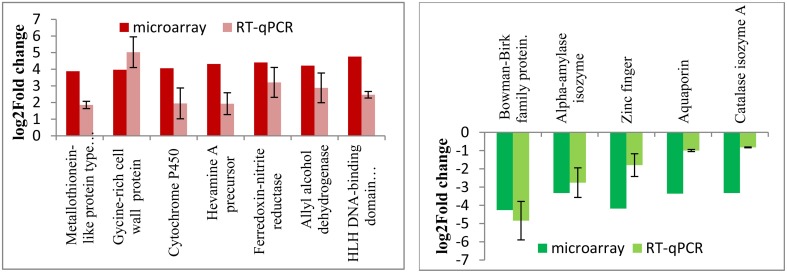
qRT-PCR validation of RGA1-regulated genes identified as common to various abiotic stresses. Out of the 1498 RGA1-regulated genes identified as common to multiple abiotic stresses on the microarray, 12 of the most up/down-regulated genes were validated by qRT-PCR. Their fold change data are shown based on averages of two biological replicates and two technical replicates of total RNA, along with microarray results. The left panel in red shows the up-regulated genes and the right panel in green shows the down-regulated genes.